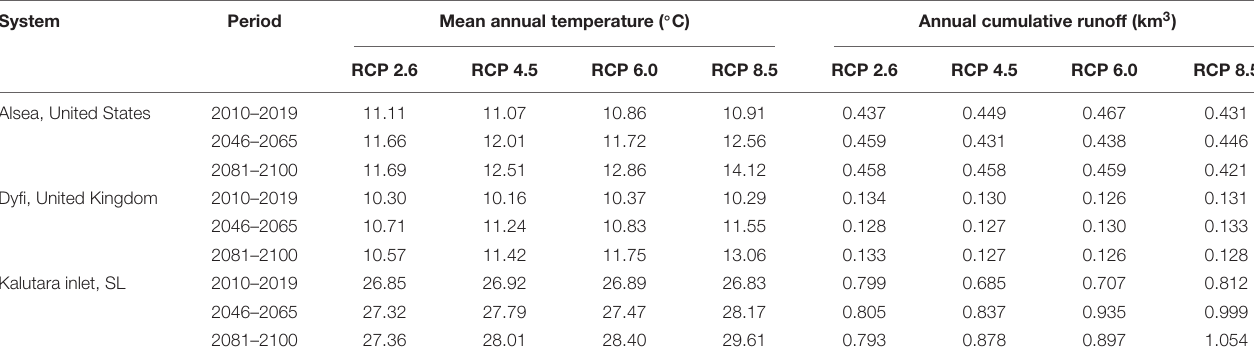
TABLE 2 | Average annual mean temperature and cumulative runoff at the selected case study locations over the present, mid-21 st century and end 21 st century time slices.